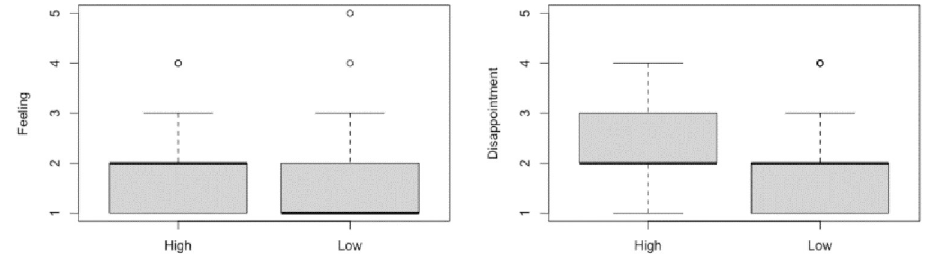
Fig 1. Box and whisker plots displaying the median and interquartile range (IQR) of responses to the feeling and disappointment question in the two conditions.